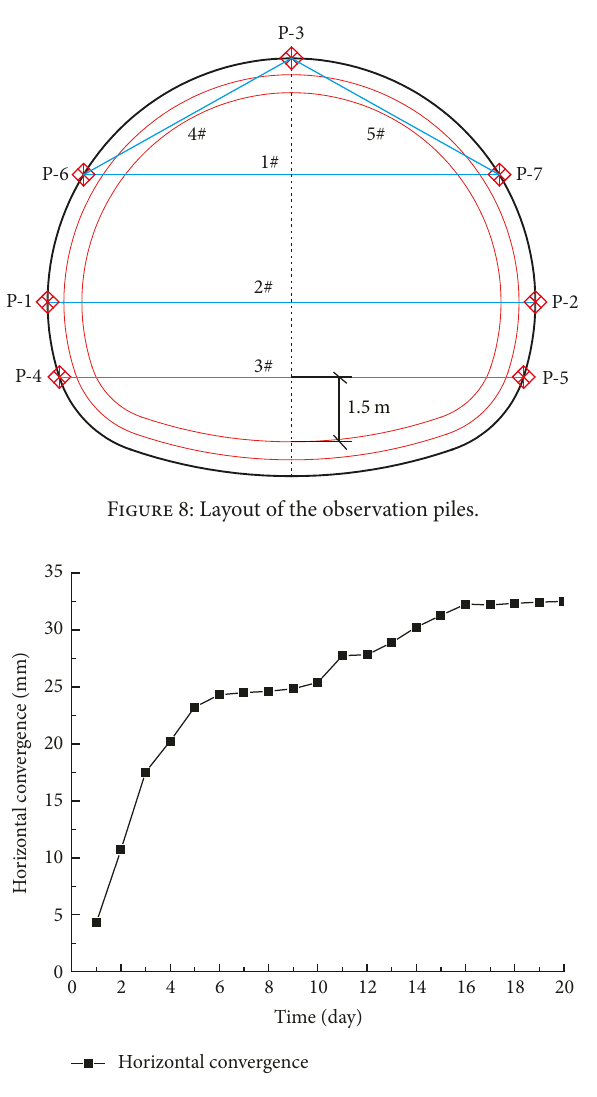
Figure 9: Horizontal convergence curve for section DK425 + 969 line 2#.